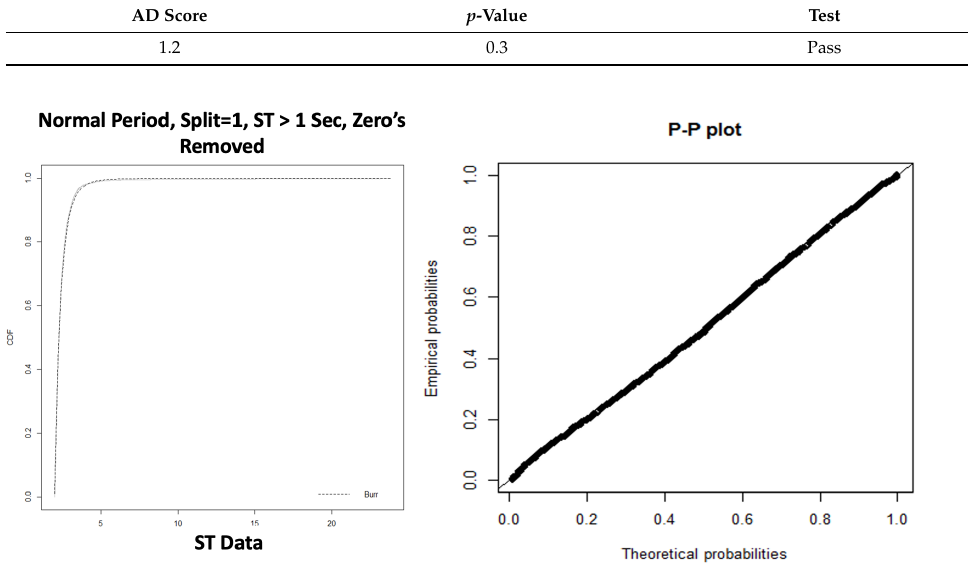
Figure 18. Normal Period, Split = ’1’, Burr Fitting, Service Times - > 1